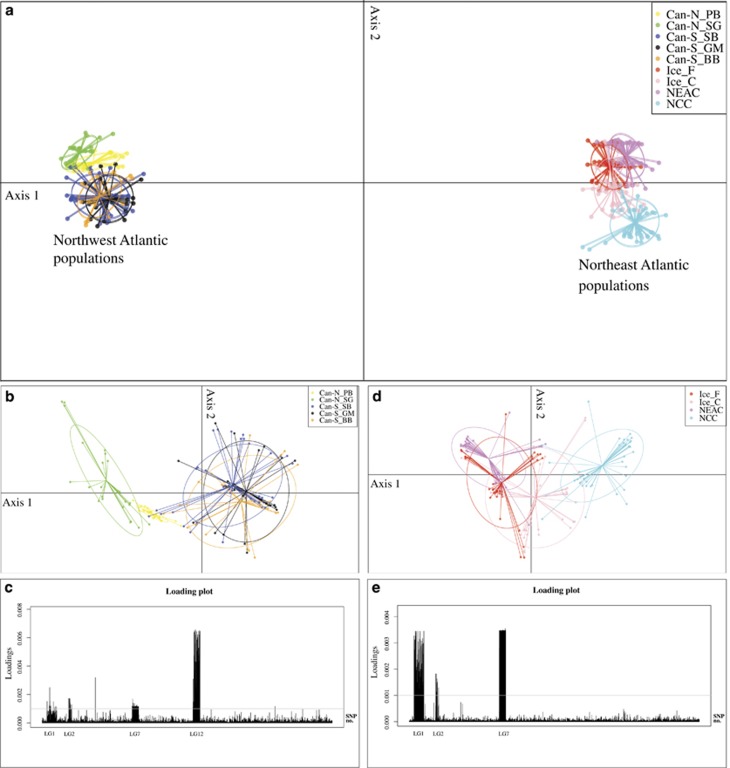
Spatial relationship between and within Northwest and Northeast Atlantic cod based on discriminant analysis of principal components (DAPC). Based on all 8165 SNPs, a distinct trans-Atlantic separation and a clear separation within Northeast and Northwest Atlantic is observed (a). The stratification within the Northwest Atlantic (b) and the Northeast Atlantic (d) is even more evident when these groups are analysed separately. The loading plots based on the DAPC analyses show the contribution of each SNP to the differentiation within the Northwest Atlantic (c) and Northeast Atlantic (e) populations. The analyses are based on n.pca=3 and n.da=2, calculated in ADEGENET that assumes a predefined population designation of the individuals. Can-N_PB, Placentia Bay; Can-N_SG, Southern Gulf of St Lawrence; Can-S_SB, Sambro; Can-S_GM, Gulf of Maine; Can-S_BB, Browns Bank; Ice_F, Iceland Frontal; Ice_C, Iceland Coastal; NEAC, Northeast Arctic cod; NCC, Norwegian coastal cod.